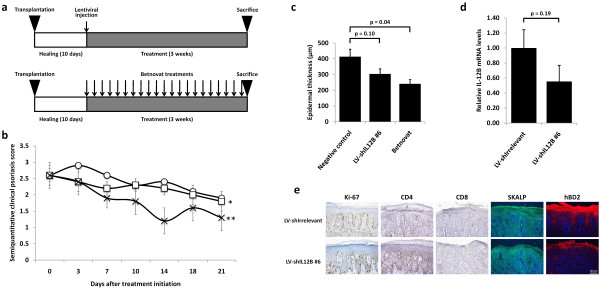
In vivo knockdown of IL-12B in xenografted psoriatic skin by lentiviral delivery of anti-IL12B shRNAs. (a) Schematic schedule of treatment with shRNA-encoding lentiviral vectors (upper panel) and topically applied steroid (lower panel). Psoriatic skin grafts were xenografted onto the back of SCID mice and allowed to heal for ten days. The skin grafts were then either left untreated or treated by a single intradermal injection of lentiviral vectors encoding either shIL12B #6 or an irrelevant shRNA, or treated daily with the topically applied class three steroid, Betnovat (positive control). The mice were sacrificed three weeks after treatment. The two groups consisting of untreated mice and mice treated with lentiviral vectors encoding an irrelevant shRNA were pooled to a single group (negative control) due to high similarities in the semiquantitative clinical psoriasis scores and epidermal thicknesses. (b) Semiquantitative clinical psoriasis scores were given twice weekly for the three-week treatment duration to mice treated with negative control (open circles, n = 16), LV-shIL12B #6 (open squares, n = 11), or Betnovat (crosses, n = 6). Intradermal injections were performed at day 0. All data points are presented as mean ± SEM. *p = 0.86, **p = 0.12. (c) At treatment endpoint three weeks post-transduction of the skin grafts, mice were sacrificed and biopsies from the skin grafts were fixed, paraffin-embedded, H&E-stained, and epidermal thickness was measured in each graft. (d) Biopsies from the xenografted psoriatic skin injected with shRNA-encoding lentiviral vectors were acquired at treatment endpoint three weeks post-transduction and evaluated for IL-12B gene expression by qRT-PCR. Data are presented as mean + SEM. (e) Immunohistochemical stainings were performed for Ki-67, CD4, CD8, SKALP/Elafin, and hBD2 on skin sections treated with LV-shIrrelevant or LV-shIL12B #6.